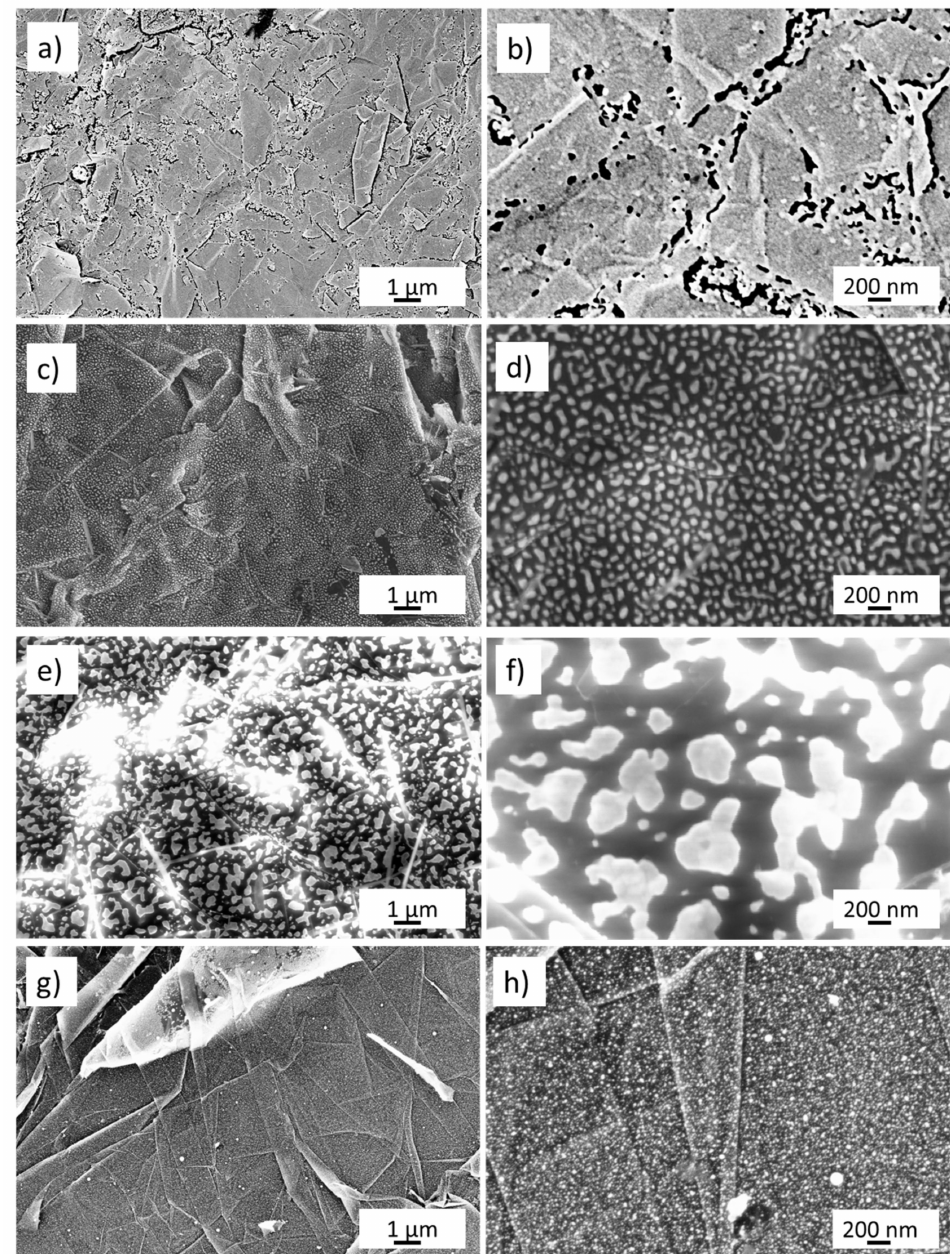
Figure 1. Field emission scanning electron microscopy pictures of ( a , b ) gold nanoporous obtained by five cycles of scanning potential between − 0.5 and 1 V in NaOH 0.1 M; ( c , d ) gold layer 8 nm thin dewetted at 300 ◦ C; ( e , f ) gold layer 17 nm dewetted at 400 ◦ C; ( g , h ) gold layer 17 nm dewetted by laser at 0.5 J cm − 2